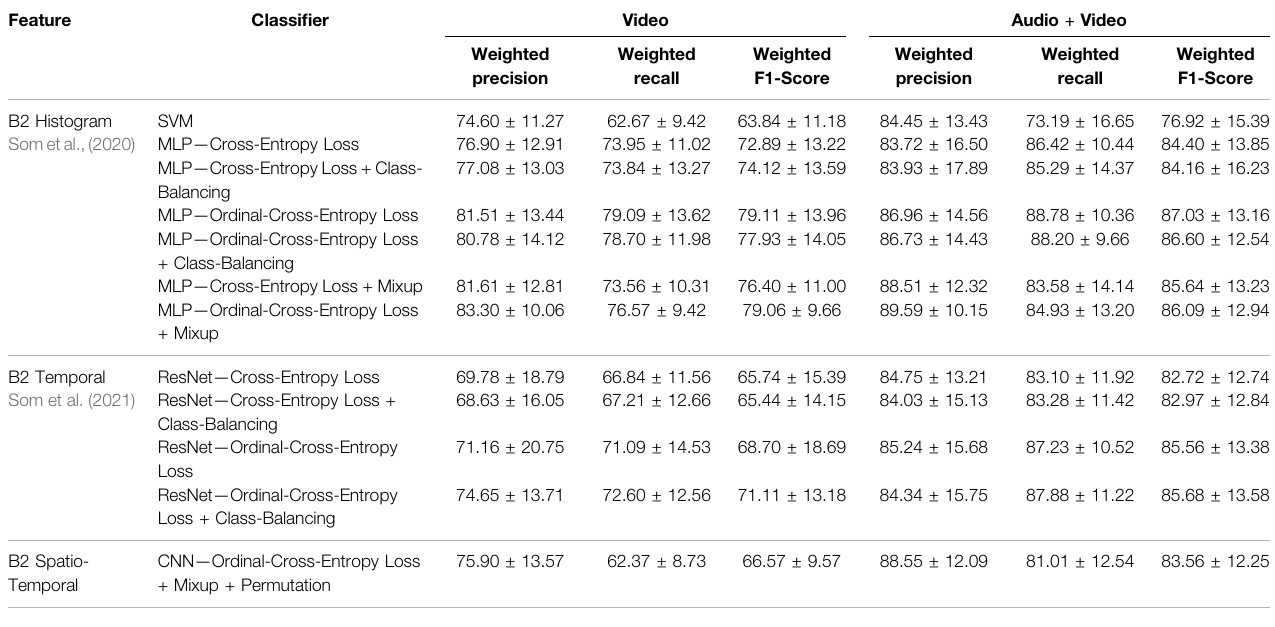
TABLE 3 | Weighted precision, weighted recall and weighted F1-score Mean ± Std measurements for the best MLP, ResNet and 2D CNN models under different settings. These models were evaluated on different feature representations extracted for Level B2.